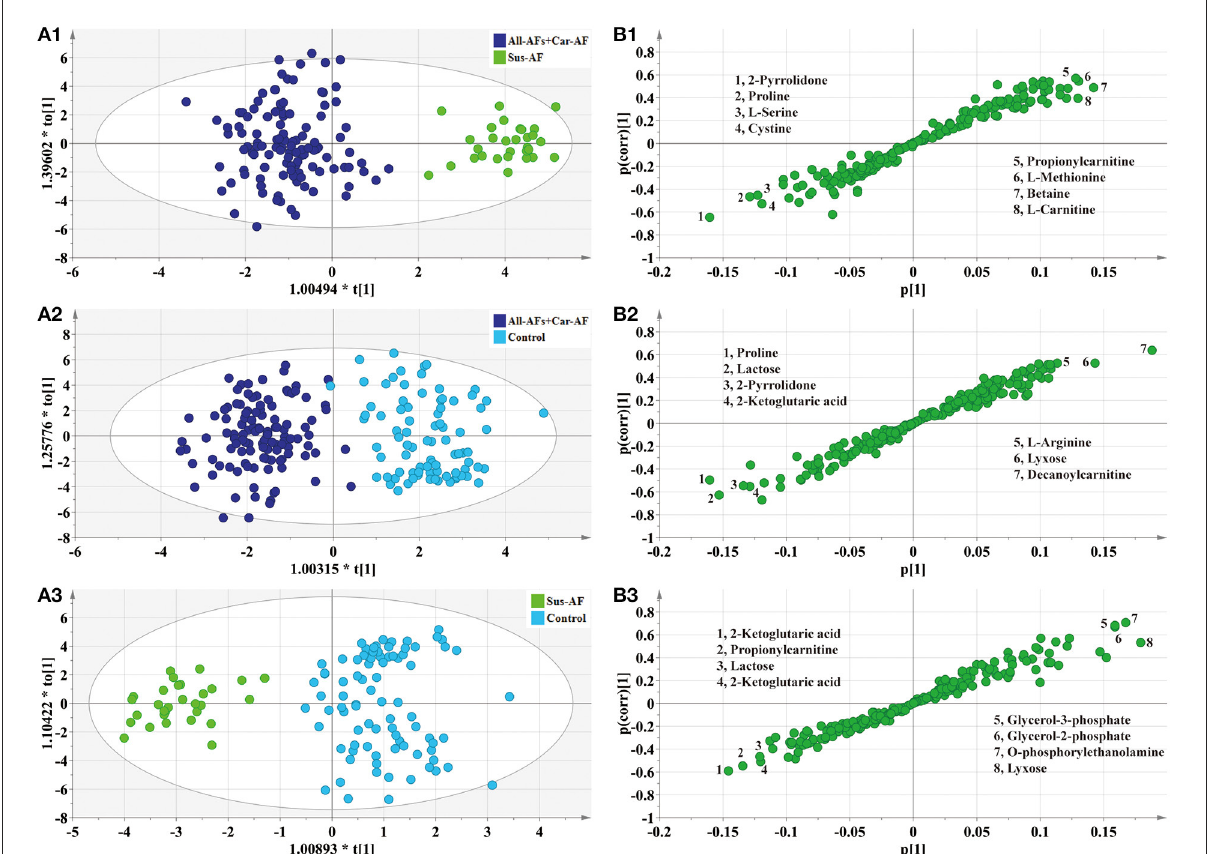
FIGURE3 OPLS-DA modeling (A) and S-plots (B) delineate different metabolic phenotypes and potential markers of Control, Sus-AF, and All-AFs plus Car-AF cardiac cases. (A1) OPLS-DA model differentiating All-AFs plus Car-AF cases from the Sus-AF cases. R2X (cum) = 0.336, R2Y (cum) = 0.863, Q2X (cum) = 0.68. Permutation tests with the intercepts of R2 < 0.468, Q2 < − 0.563. (B1) S-plot highlights the potential markers of the All-AFs plus Car-AF versus Sus-AF cases. (A2) OPLS-DA model differentiating All-AFs plus Car-AF cardiac cases from the Control. R2X (cum) = 0.339, R2Y (cum) = 0.848, Q2X (cum) = 0.736. Permutation tests with the intercepts of R2 < 0.368, Q2 < − 0.454. (B2) S-plot highlights the potential markers of the All-AFs plus Car-AF versus Control cases. (A3) OPLS-DA model differentiating Sus-AF cases from Control. R2X (cum) = 0.301, R2Y (cum) = 0.842, Q2X (cum) = 0.704. Permutation tests with the intercepts of R2 < 0.452, Q2 < − 0.475. (B3) S-plot highlights the potential markers of the Sus-AF versus Control